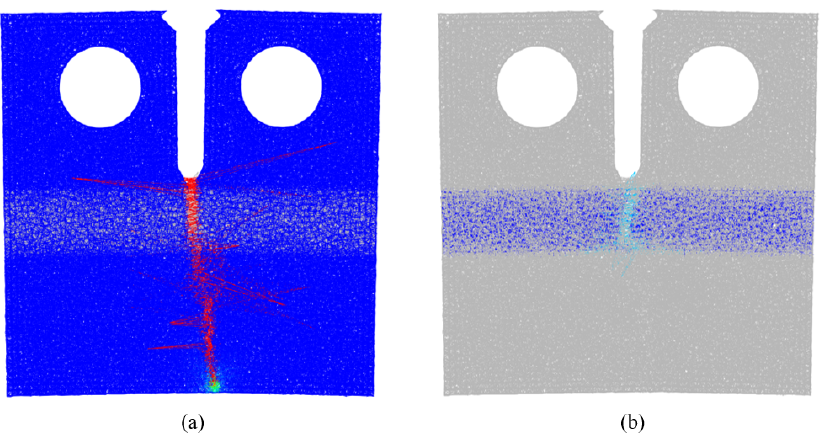
Figure 14. Crack path in the MS of a CT specimen containing a MS-TiC cylindrical reinforcement ( a ) and in the MS-TiC cylindrical insert ( b